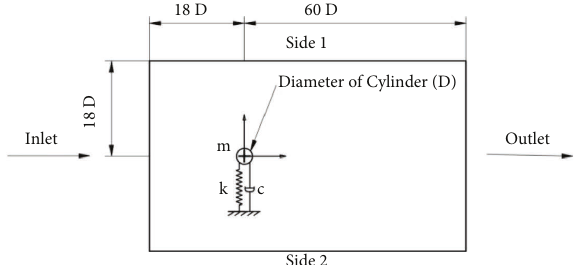
Figure 1: Schematic view of vortex-induced vibration of the elastically supported